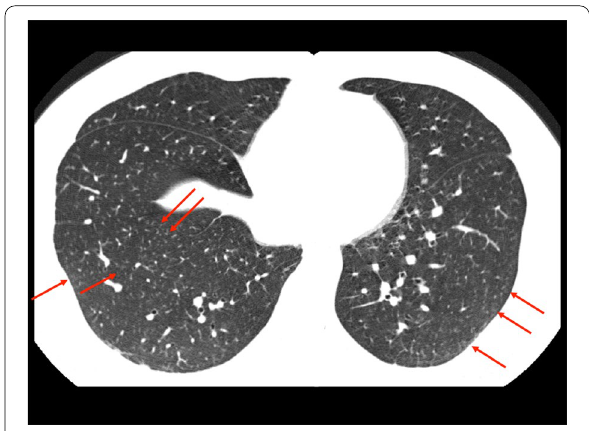
Fig. 7 HRCT scan of a 34-year-old man with indium lung. Tiny centrilobular nodules (arrows) are scattered in both lungs